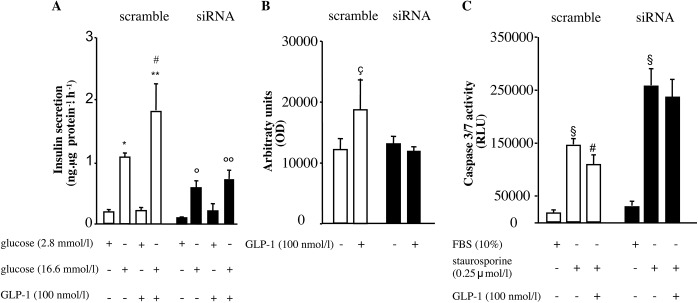
GLP-1 effects on insulin secretion, proliferation and apoptosis are impaired in insulin receptor knockdown cells.Panel A. Insulin secretion in INS-1E cells, transfected with insulin receptor siRNA. Cells were incubated with 2.8 or 16.6 mmol/l glucose in the absence or presence of GLP-1 (100 nmol/l). Values are expressed as means ± SD of three independent experiments (*p<0.05 vs. scramble cells exposed to 2.8 mmol/l glucose; ** p<0.05 vs. scramble cells exposed to 2.8 mmol/l glucose plus 100 nmol/l GLP-1; #vs. scramble cells exposed to 16.6 mmol/l glucose; °p<0.05 vs. siRNA cells exposed to 2.8 mmol/l glucose; °° siRNA cells exposed to 2.8 mmol/l glucose plus 100 nmol/l GLP-1). Panel B. Cell proliferation, assessed by BrdU incorporation, in INS-1E cells transfected with insulin receptor siRNA. Cells were switched to serum free medium for 12 hours and then incubated for 48 hours in the absence or presence of GLP-1 (100 nmol/l). Values are expressed as means ± SD of four independent experiments, each comprising three wells (ç p<0.05 vs. untreated scramble cells). Panel C. Apoptosis, assessed by caspase 3/7 activity, in INS-1E cells transfected with insulin receptor siRNA. Cells were treated with staurosporine (0.25μmol/l, 2 hours) in the absence or presence of 100 nmol/l GLP-1. Treatment with GLP-1 significantly decreased apoptosis induced by staurosporine in scramble control cells but not in siRNA transfected cells. Values are expressed as means ± SD of nine independent experiments, each comprising three wells. (§ p<0.05 vs. untreated scramble or siRNA transfected cells; # p<0.05 vs. scramble cells treated with staurosporine in the absence of GLP-1).